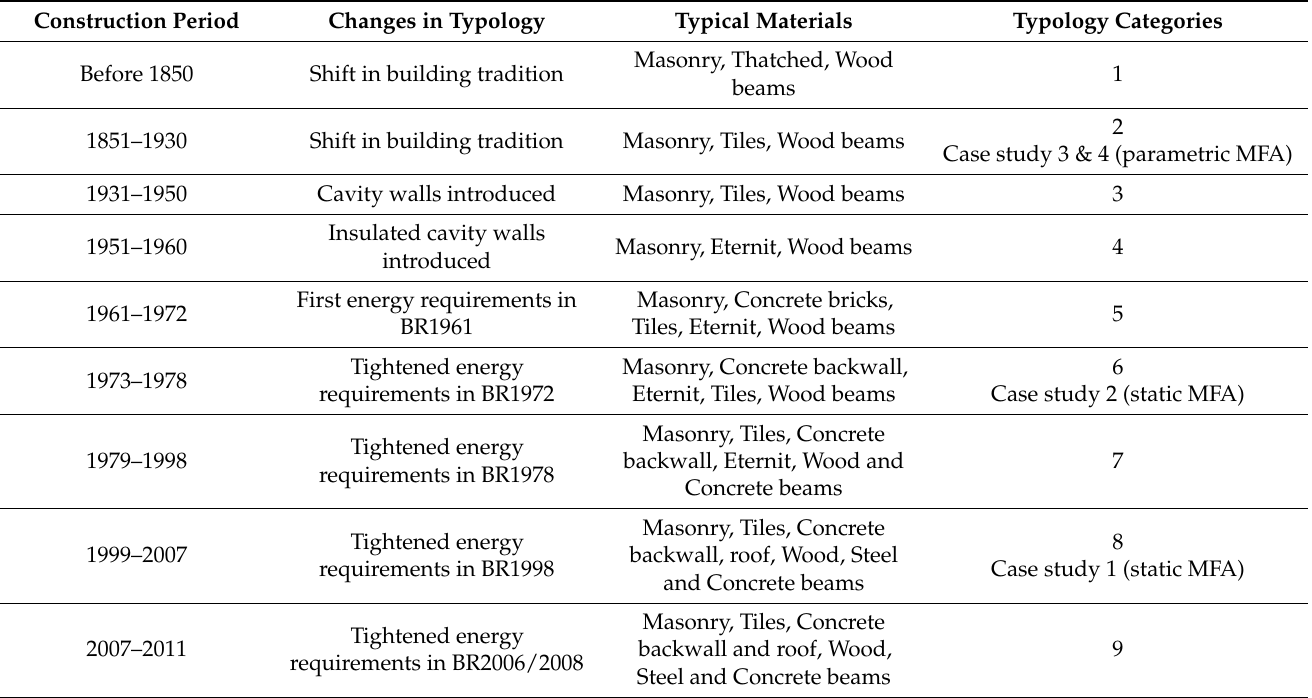
Table 2. Danish typology based on construction periods in TABULA [49] focusing on energy require- ments. BR is the Danish Building